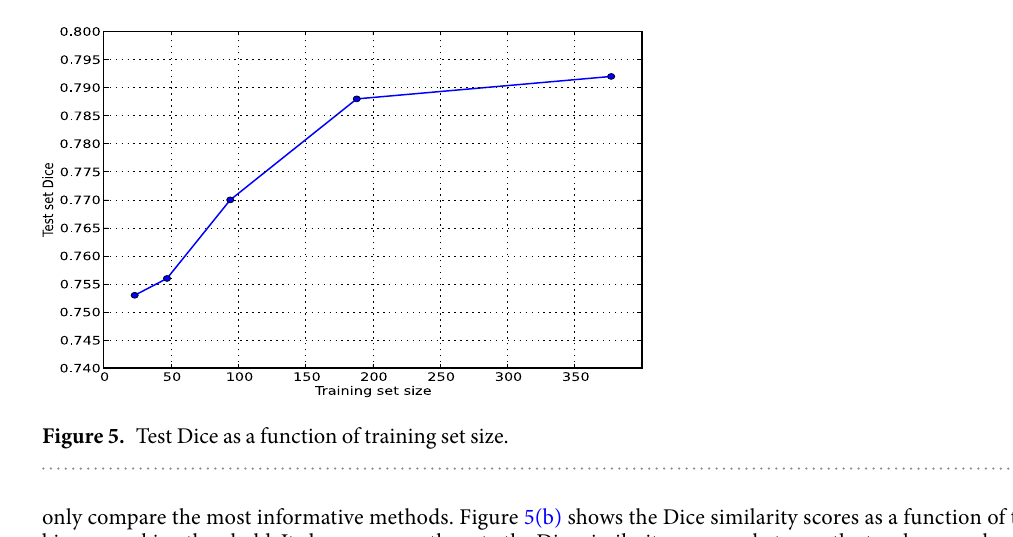
only compare the most informative methods. Figure 5(b) shows the Dice similarity scores as a function of the binary masking threshold. It also compares them to the Dice similarity measure between the two human observ- ers. 95% confidence intervals are depicted for each curve, as a result of bootstrapping on patients. The effect of the training dataset size can be observed in Table 6 and Fig. 5.